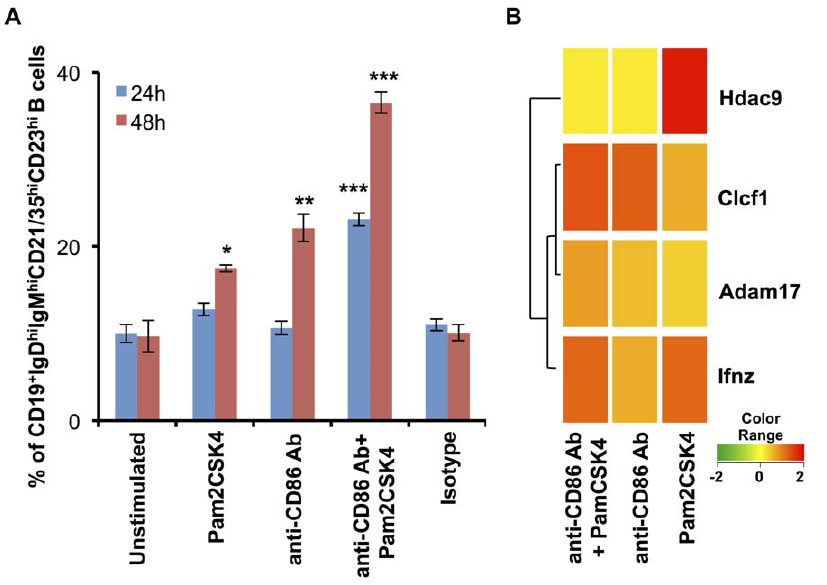
Figure 3. Simultaneous signaling through CD86 and TLR-2 preferentially differentiates RB cells into marginal zone cells. Signaling was delivered in RB cells isolated from BALB/c with anti-CD86 Ab and Pam2CSK4. (A) Bar diagrams show marginal zone precursors (CD19 + , IgD hi IgM hi CD21/35 hi CD23 hi ) in differentially stimulated RB cells at 24 h and 48 h. Values indicate the mean 6 SEM of percent populations of IgD hi IgM hi CD21/35 hi CD23 hi expressing cells. Data are representative of three independent experiments. Statistical analysis was done by Student‘t’ test. ‘*’, ‘**’, ‘***’ indicates p , 0.05, p , 0.01, p , 0.001, respectively. (B) Dendrograms depict upregulation in genes involved in differentiation of RB cells with respect to unstimulated controls in different color codes (yellow: no change, red: upregulation, green: downregulation). The values indicate geometric mean of fold change of two of the biological replicates.